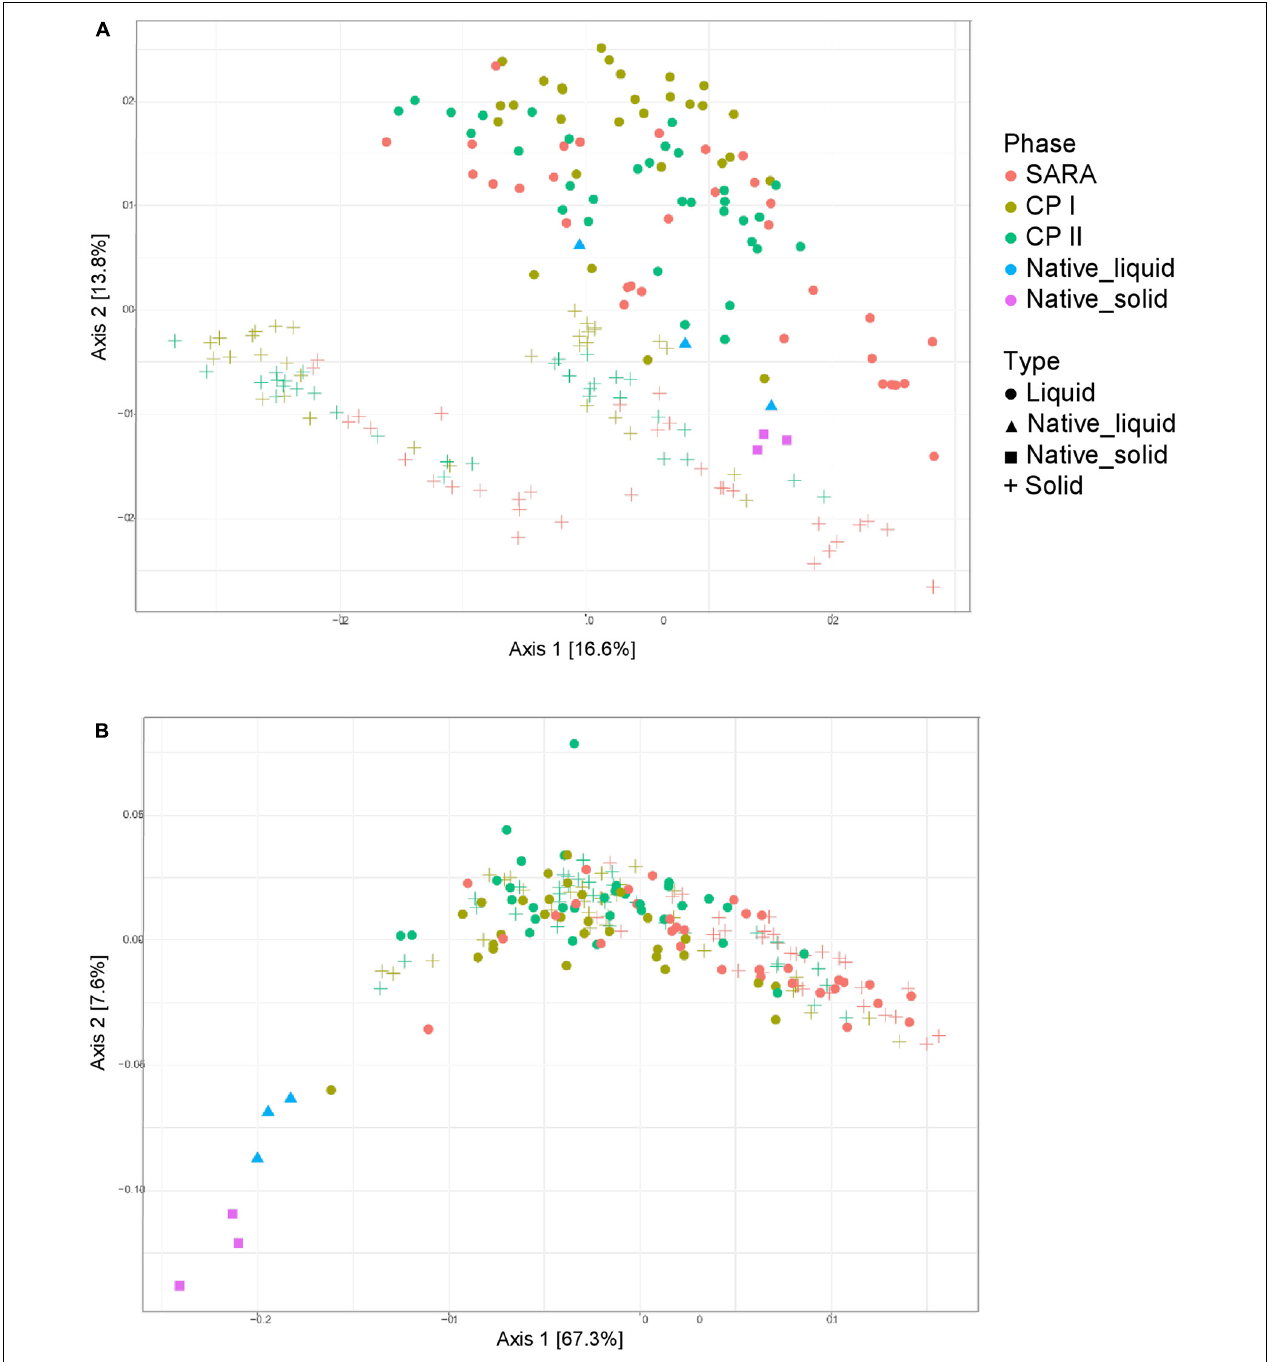
FIGURE 3 | Unweighted (A) and weighted (B) UniFrac distances of samples analyzed by PacBio sequencing. Samples of control period I (CP I, colored in green) and control period II (CP II, colored in turquoise), and during SARA conditions (SARA, colored in red) are presented for the liquid (dots) and solid phase (crosses).